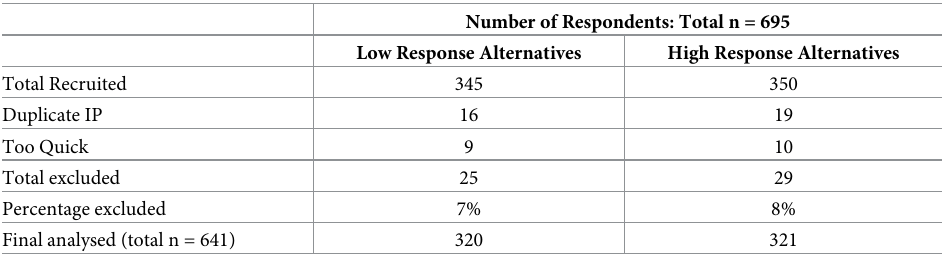
Table 3. Respondent flow showing the allocation into conditions and those excluded for a duplicate IP addresses or responding too